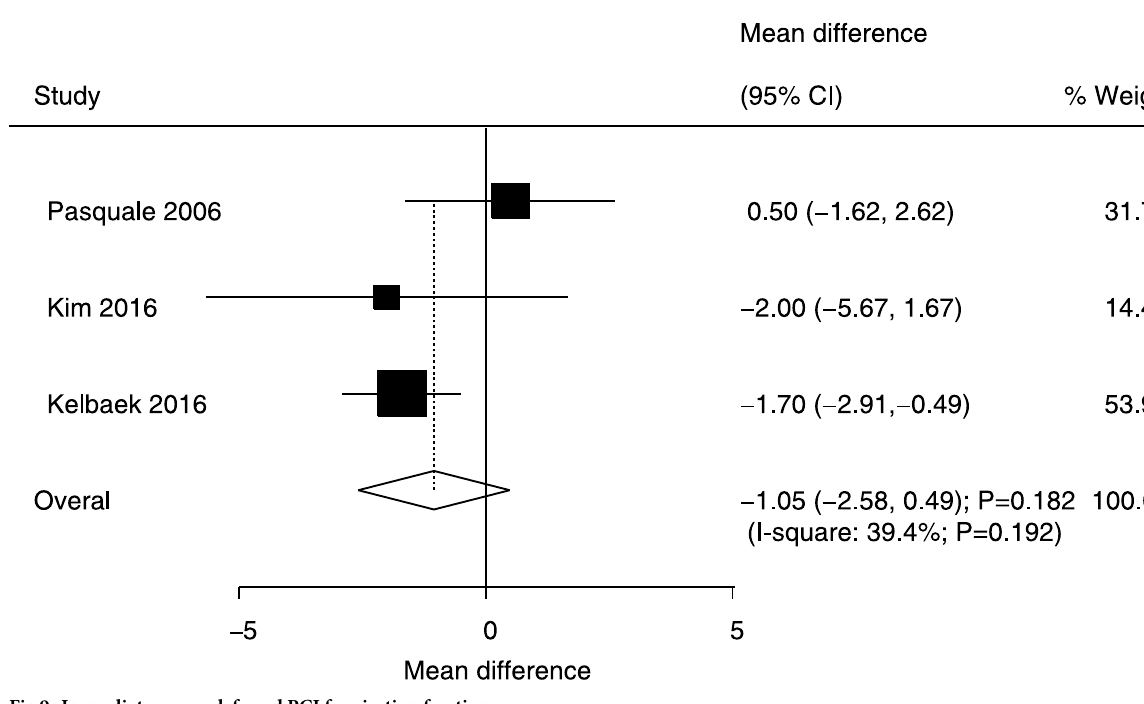
Fig 9. Immediate versus deferred PCI for ejection